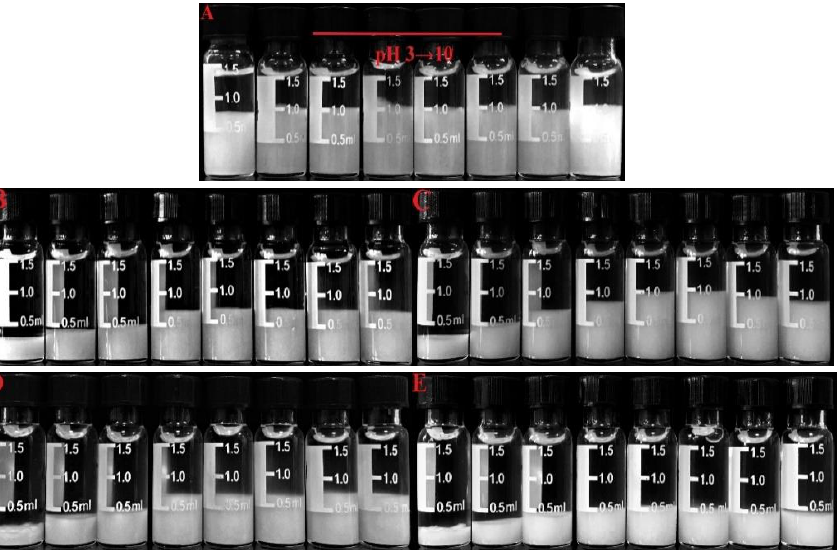
Figure 6. The pH-responsive behavior of hydrogels: ( A ) Gel 1; ( B ) Gel 2; ( C ) Gel 3; ( D ) Gel 4; ( E ) Gel 5.